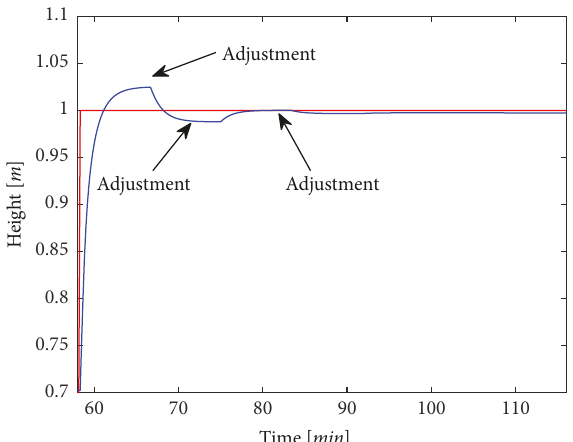
Figure 18: Detail of the adaptive control system